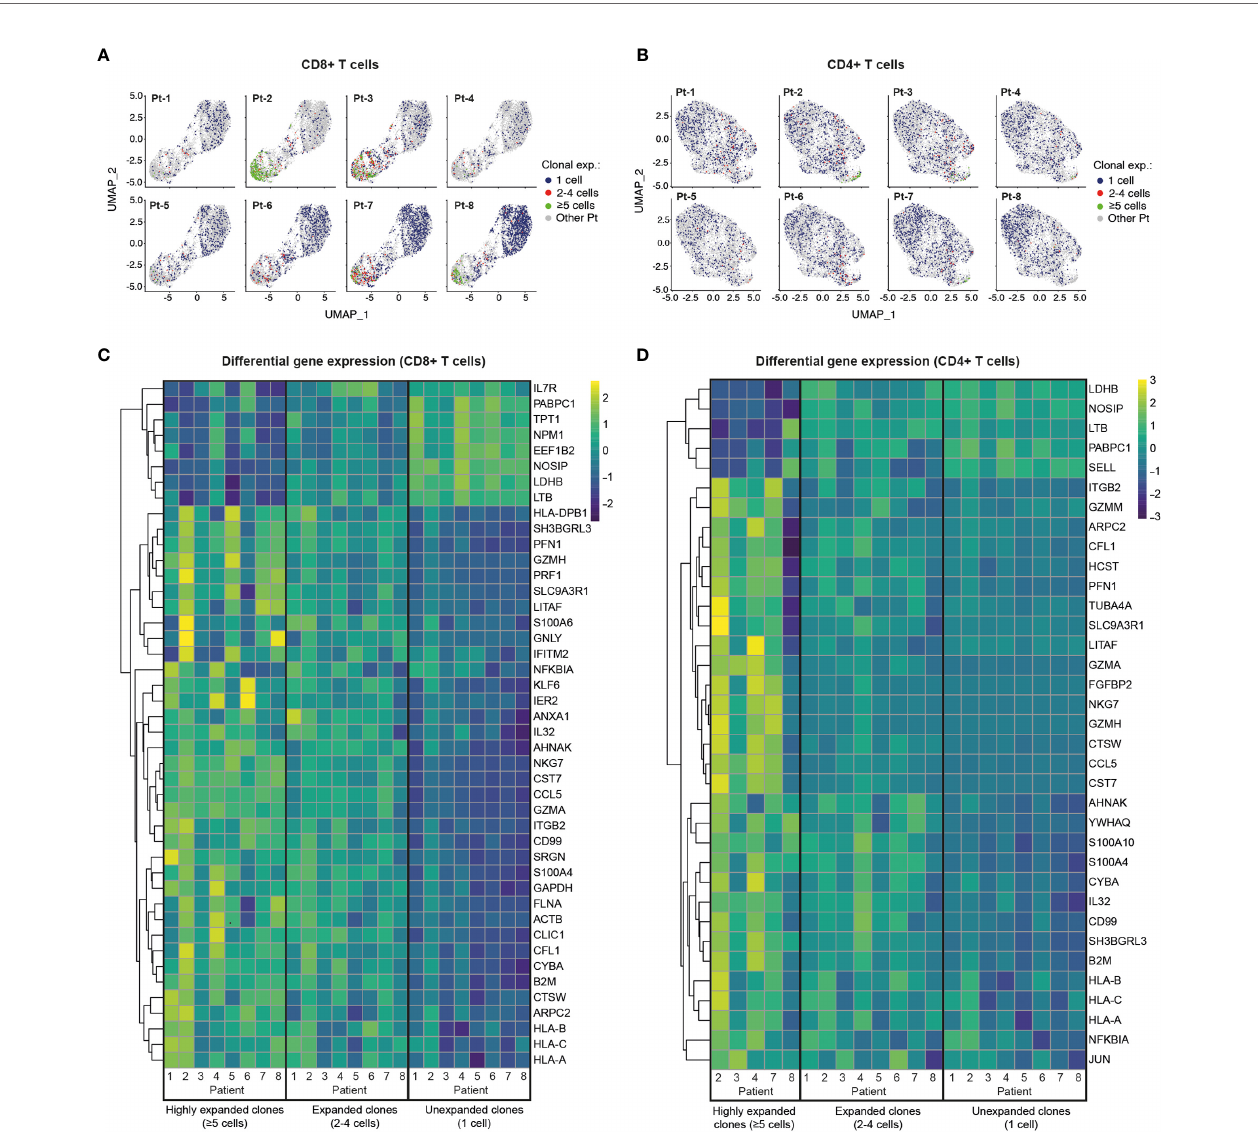
FIGURE 4 | Single-cell transcriptome and TCR sequencing reveals preferential clonal expansion in effector T cells. (A, B) , UMAP plots display CD8+ (A) and CD4+ (B) T cells from speci fi c patients according to their clonal expansion levels. T cells from other patients in each individual plot are shown in grey. (C, D) , Heatmaps show differential gene expression (DGE) in unexpanded, expanded and highly expanded CD8+ (C) or CD4+ (D) T cells. Genes were fi ltered to include those with detectable expression in at least 50% of cells and that had a minimum 50% fold-change in expression level between